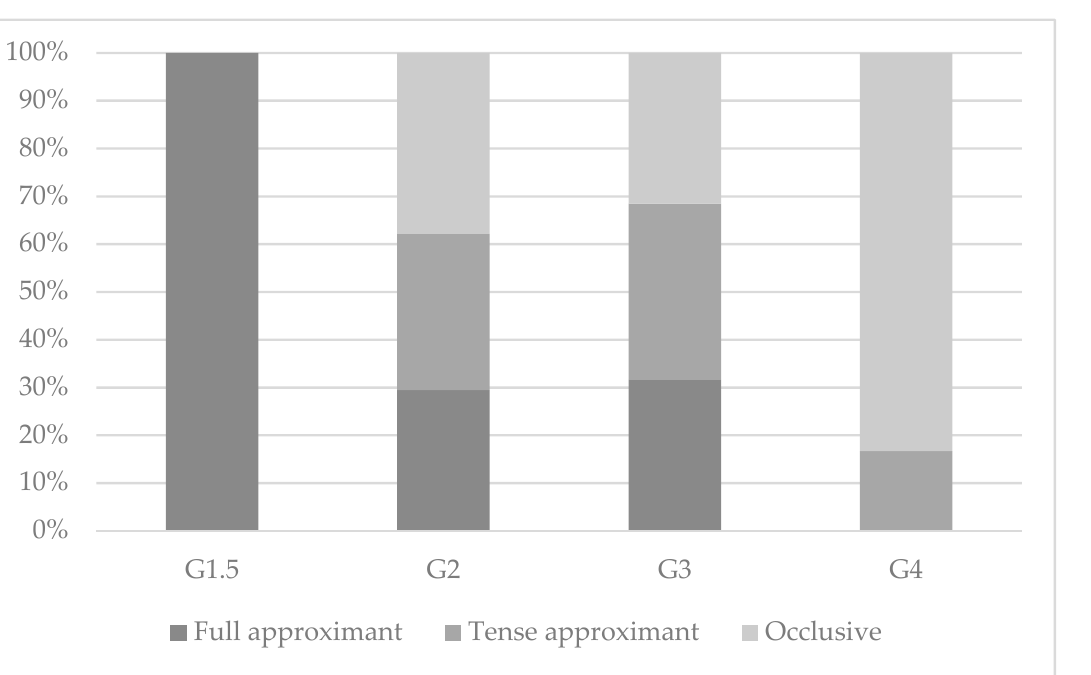
Figure 8. Rates of /g/ production types by generation.